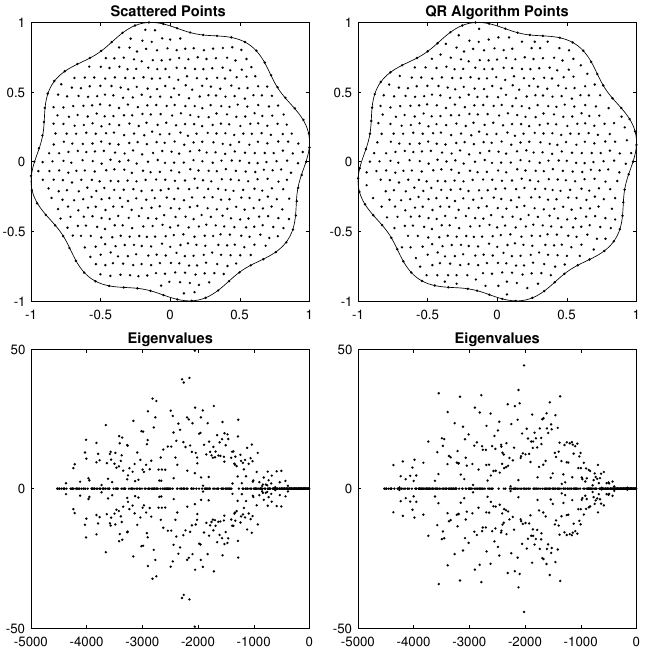
Figure 17. Scattered repel algorithm points and resulting MCpQR points with Dirichlet Lapla- cian